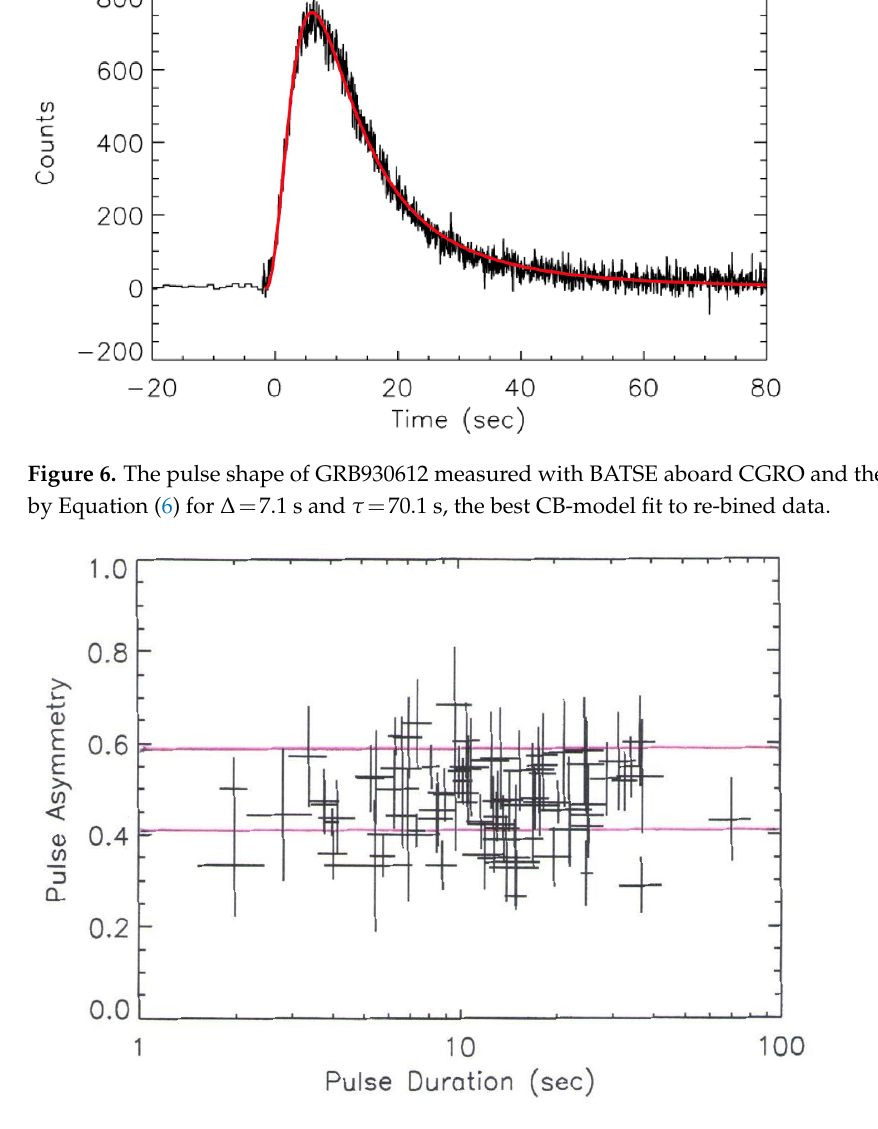
Figure 7. Comparison between the observed asymmetry ratio RT/DT as function of pulse duration reported in [80] for a sample of 77 resolved LGRB pulses measured with BATSE aboard CGRO (with a mean value RT/DT = 0.47 ± 0.08), and the CB model predicted asymmetry 0.41 < RT/DT < 0.58 for ∆ < τ < ∞ (solid